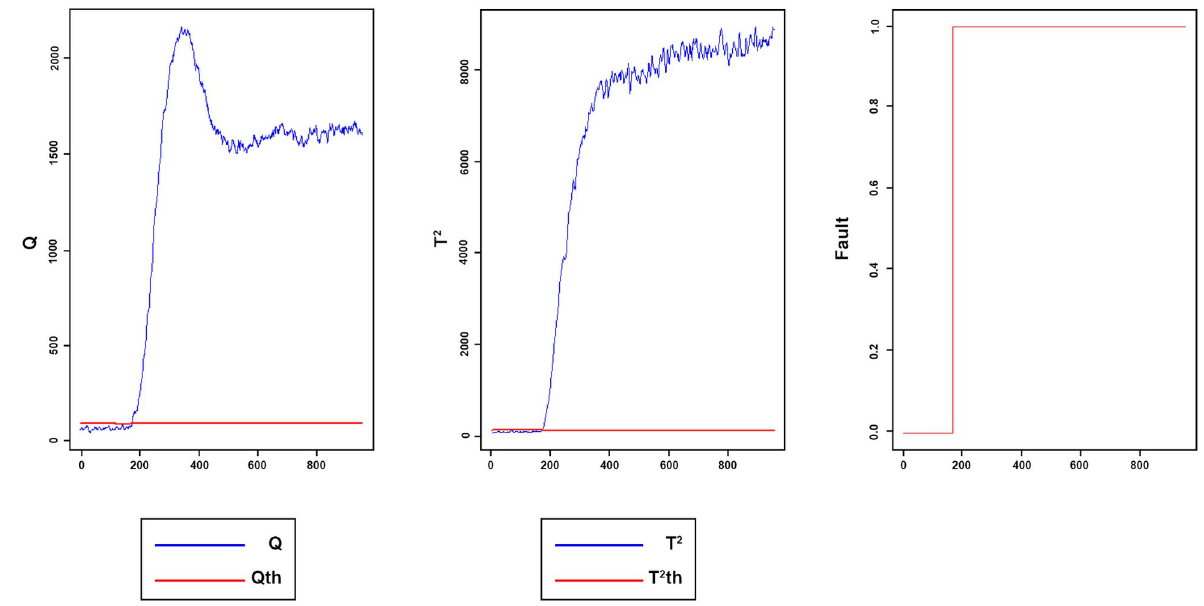
Fig 8. Monitoring performance of MWDPCA for fault